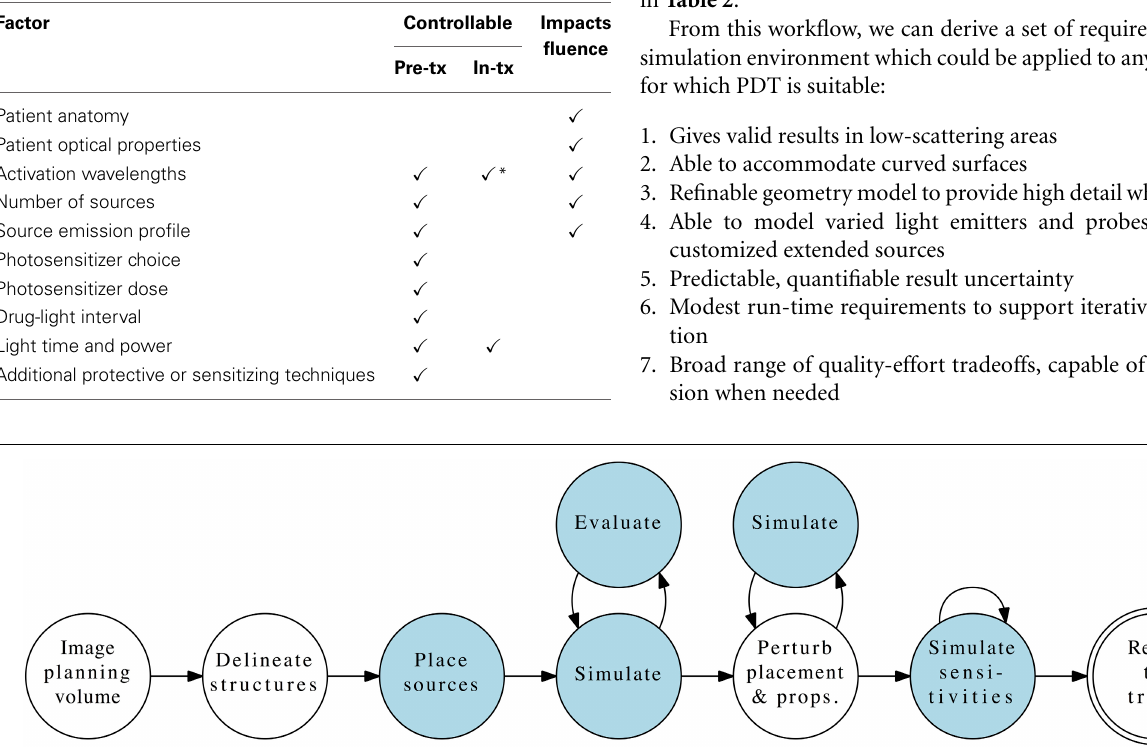
FIGURE 1 | Complete PDT pre-treatment planning workflow, with the phases contributed by this article highlighted.